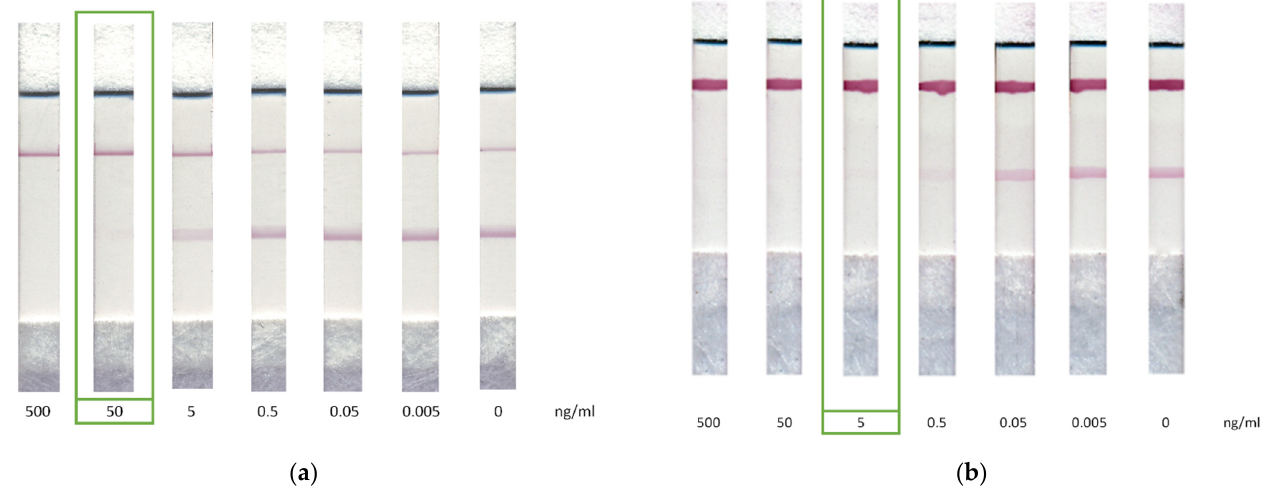
Figure 5. LFIA of CAP by ( a ) standard competitive scheme and ( b ) double competitive scheme. The appearance of test strips after the assays.